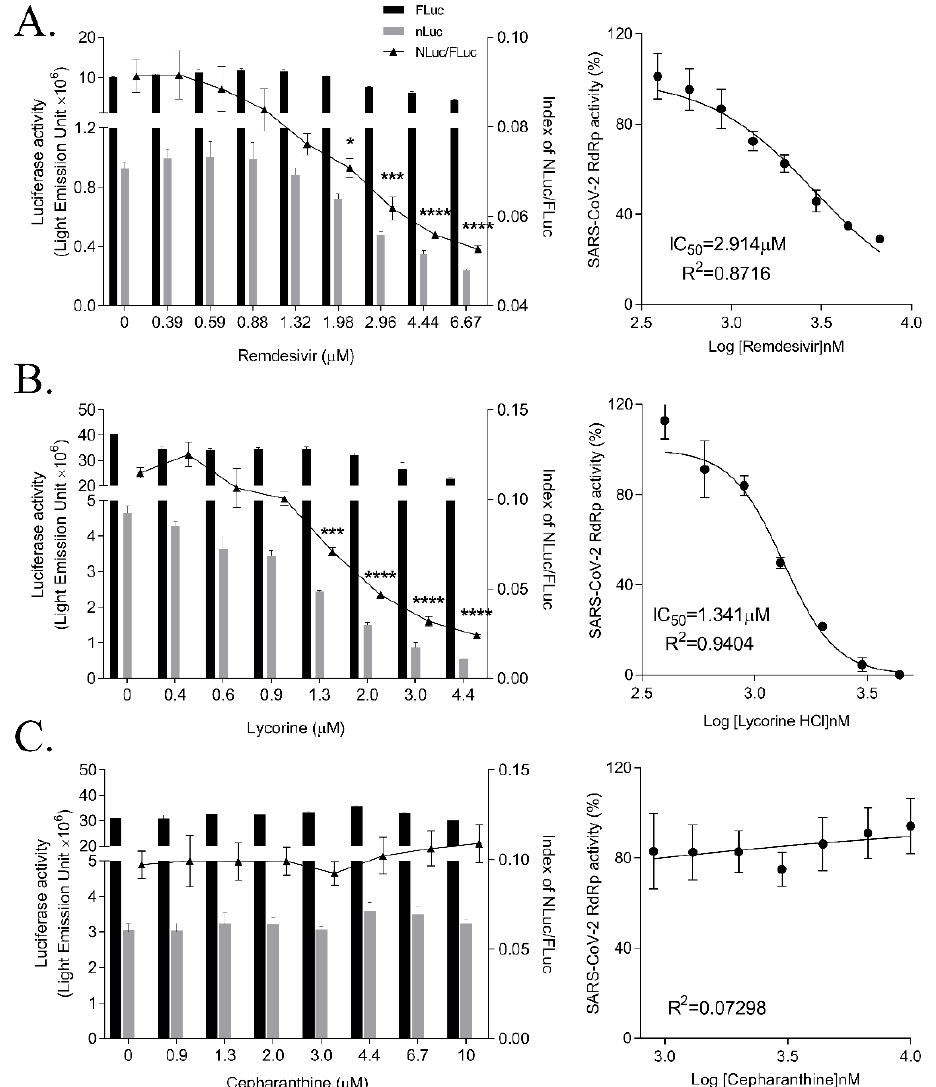
Figure 4. Effect of remdesivir, lycorine and cepharanthine on SARS-CoV-2 RdRp activity. HEK293T cells were transfected with p(+)FLuc-( − )UTR-NLuc and pCI-SARS2-nsp12N. After 6 h, the cells were treated with serially diluted- remdesivir ( A ), lycorine ( B ), or cepharanthine ( C ) for 15 h. FLuc and NLuc activities were measured and NLuc/FLuc ratios were determined. Statistical comparisons were conducted using one-way analysis of variance (ANOVA) followed by Bonferroni’s multiple comparison test. * p < 0.05; *** p < 0.001; **** p < 0.0001 vs. 0 µ M (left graph). The IC 50 values were calculated using non-linear regression analysis (right graph). The data were representative of at least three independent experiments and presented as mean ± standard error of the mean.